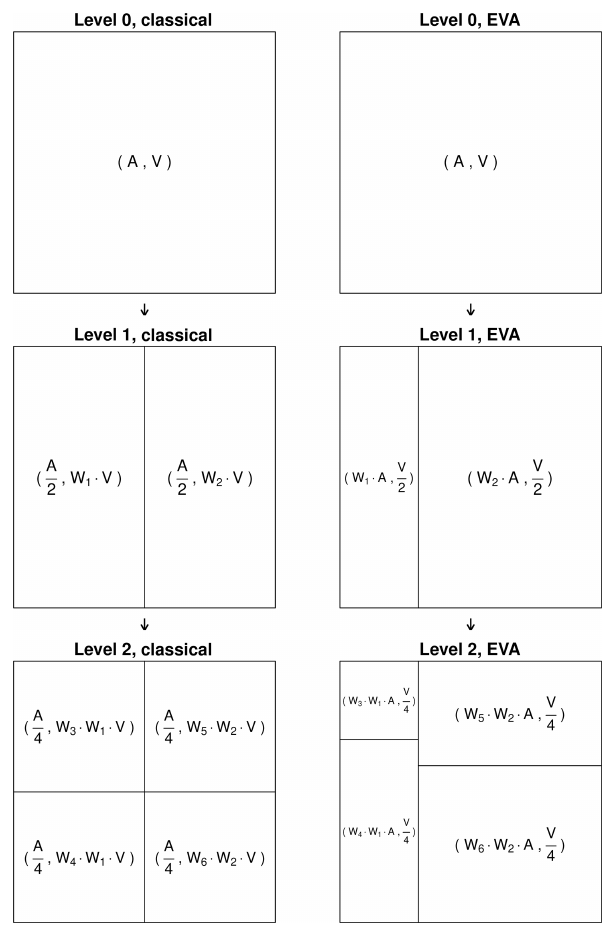
Figure 1. Schematic of the branching rules for the classical and equal-volume area (EVA) random cascades. The area is denoted by A and the rainfall volume by V . The random weights are W 1 − W 6